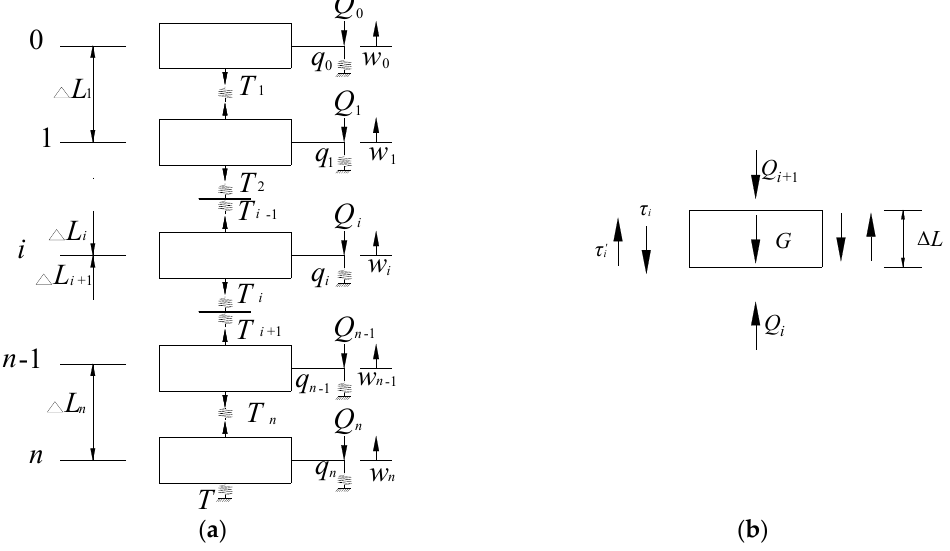
Figure 3. Pile–soil interaction and micro-unit force model. ( a ) Pile–soil interaction model. ( b ) Differential element force analysis.